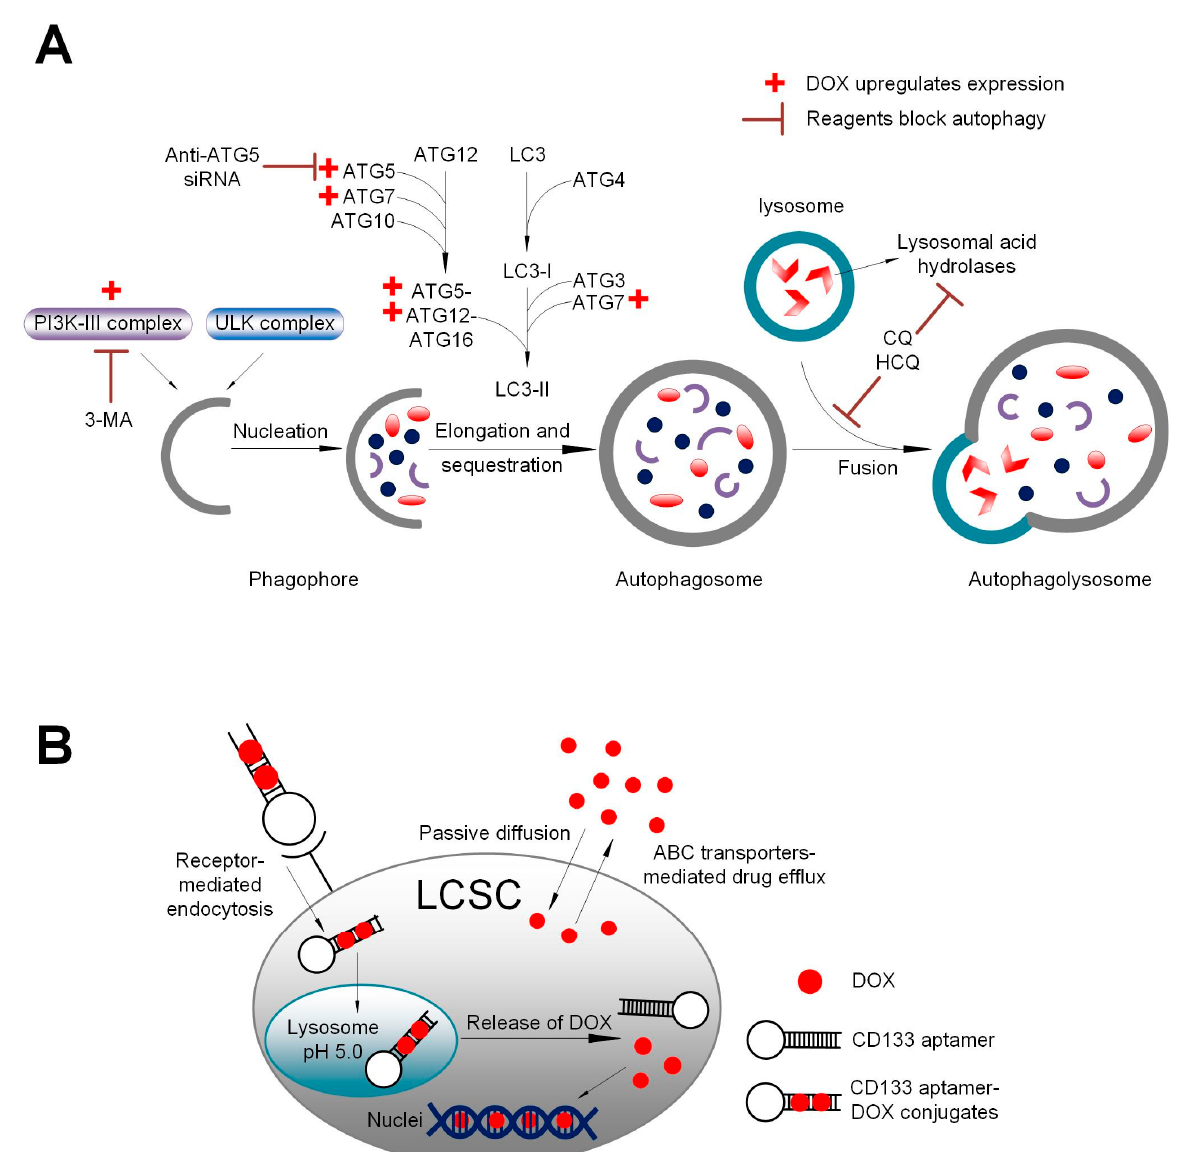
Figure 6. A schematic summary. ( A ) Schematic illustration of the impact of DOX, autophagy inhibitor 3-methyladenine (3-MA), and downregulation of autophagy-related 5 (ATG5) on autophagy. Class III phosphoinositide 3-kinase (PI3K-III) complex and ATG5 are critical components in autophagosome formation. DOX upregulates the formation of PI3K-III complex and ATG5, thus facilitating autophagosome formation. In contrast, 3-MA inhibits the formation of PI3K-III complex, while anti-ATG5 siRNA downregulates ATG5 expression. ( B ) Schematic summary of aptamer-guided targeted delivery of DOX into liver cancer stem cells. Upon binding to the CD133-positive cancer cells, the aptamer-conjugated DOX is efficiently internalized via receptor-mediated endocytosis, thus bypassing the drug efflux mediated by ABC transporters on the plasma membrane. Following endocytosis, DOX is released from the CD133 aptamer from endolysosomes. The free DOX is able to gain entry into the nuclei and induce apoptosis via binding to the DNA and poisoning topoisomerase II. LCSC: liver cancer stem cells; ABC transporter: ATP-binding cassette transporter.